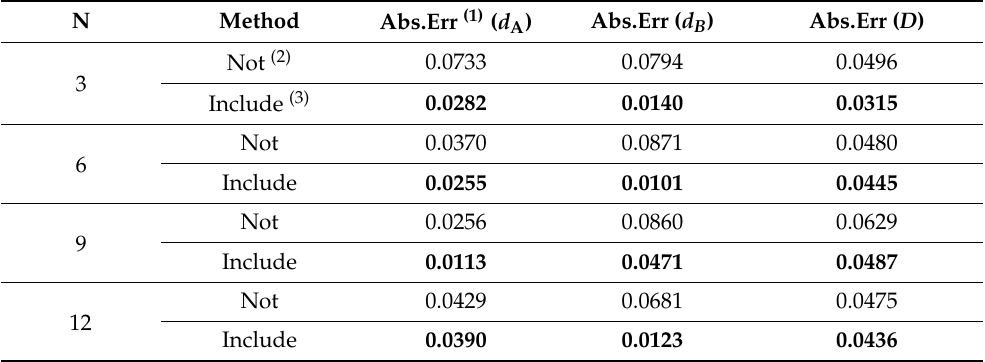
Table 4. Accuracy comparison between two gradient computing methods by measuring a dumbbell gauge. (Unit: mm).